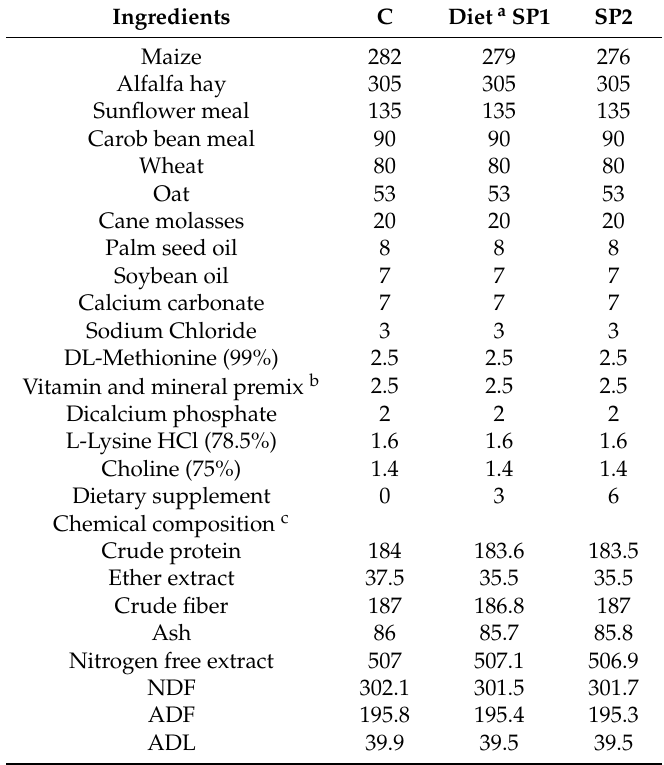
Table 1. Ingredients (g / kg) and chemical composition of experimental